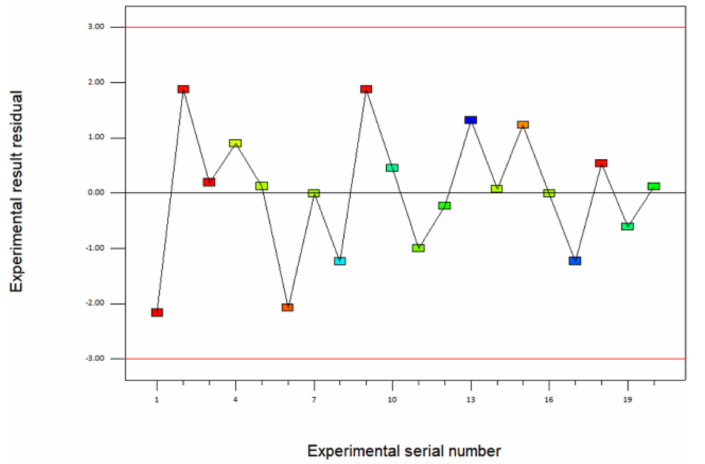
Figure 8. Correspondence between experimental serial number and experimental result residual.